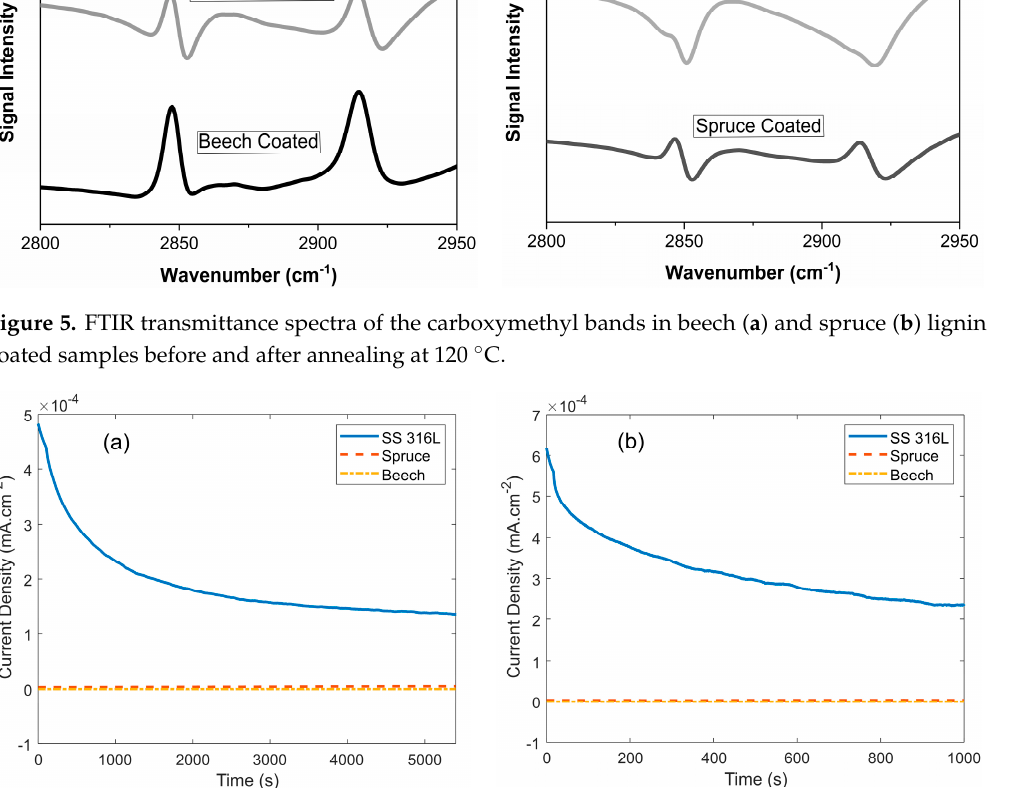
Figure 6. Polarization diagram of samples to +50 mV vs OCP (OCP beech/spruce ≈ 50 mV, OCP stainless steel ≈ − 50 mV vs Ag/AgCl) in SBF solution. Full duration (5400 s) ( a ) and first 1000 s of measurement ( b ).